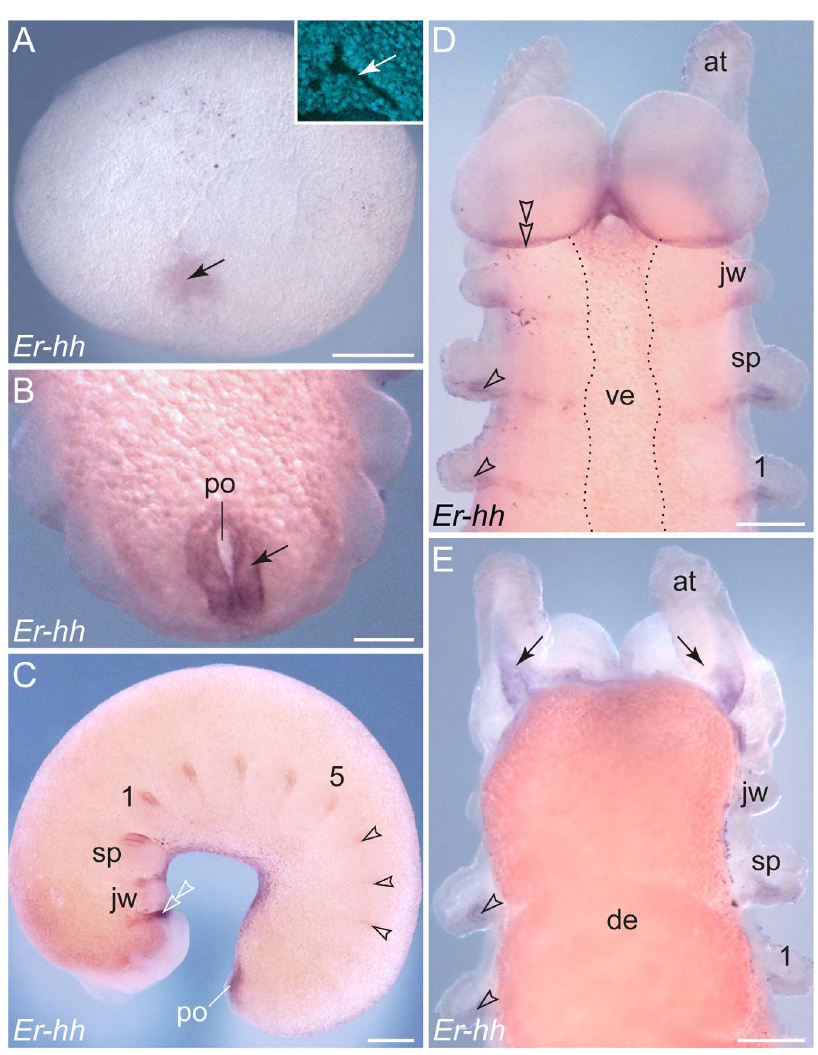
Figure 10. Expression of hedgehog in embryos of E. rowelli . Leg-bearing segments and corresponding limbs are numbered. Arrowheads indicate segmentally repeated stripes in the posterior portion of each developing limb. (A) Stage I embryo. Inset in the upper right corner shows a fluorescent micrograph (DNA labelling) of the blastoporal area from the same embryo. Arrows point to the position of the blastopore, which is surrounded by hedgehog expressing cells. (B) Posterior end of a stage IV embryo. Arrow indicates the expression around the proctodaeum. (C) Stage III embryo in lateral view showing repeated stripes of expression along the body. Arrowheads point to the emerging hedgehog domains in the posterior portion of each developing limb in the posterior half of the embryo. Note an elongated domain at the posterior border of the cephalic lobes (double-arrowhead). (D) Anterior end of a stage IV embryo in ventral view. Double- arrowhead points to the elongated domain at the posterior border of the cephalic lobes. Dotted line indicates the border between the ectoderm and the ventral extra-embryonic tissue. (E) Dorsal view of the same embryo as in D. Arrows point to the expression in the mesoderm at the bases of the developing antennae. Abbreviations: at , developing antenna; de , dorsal extra-embryonic tissue; jw , embryonic jaw; po , proctodaeum; sp , embryonic slime papilla; ve , ventral extra-embryonic tissue. Scale bars: 500 m m (A), 100 m m (B), 250 m m (C), 200 m m (D,